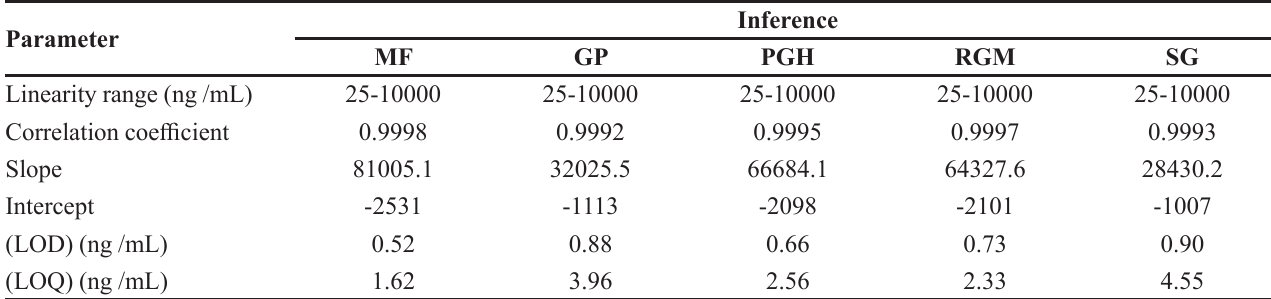
TABLE II - Linearity and sensitivity of the method